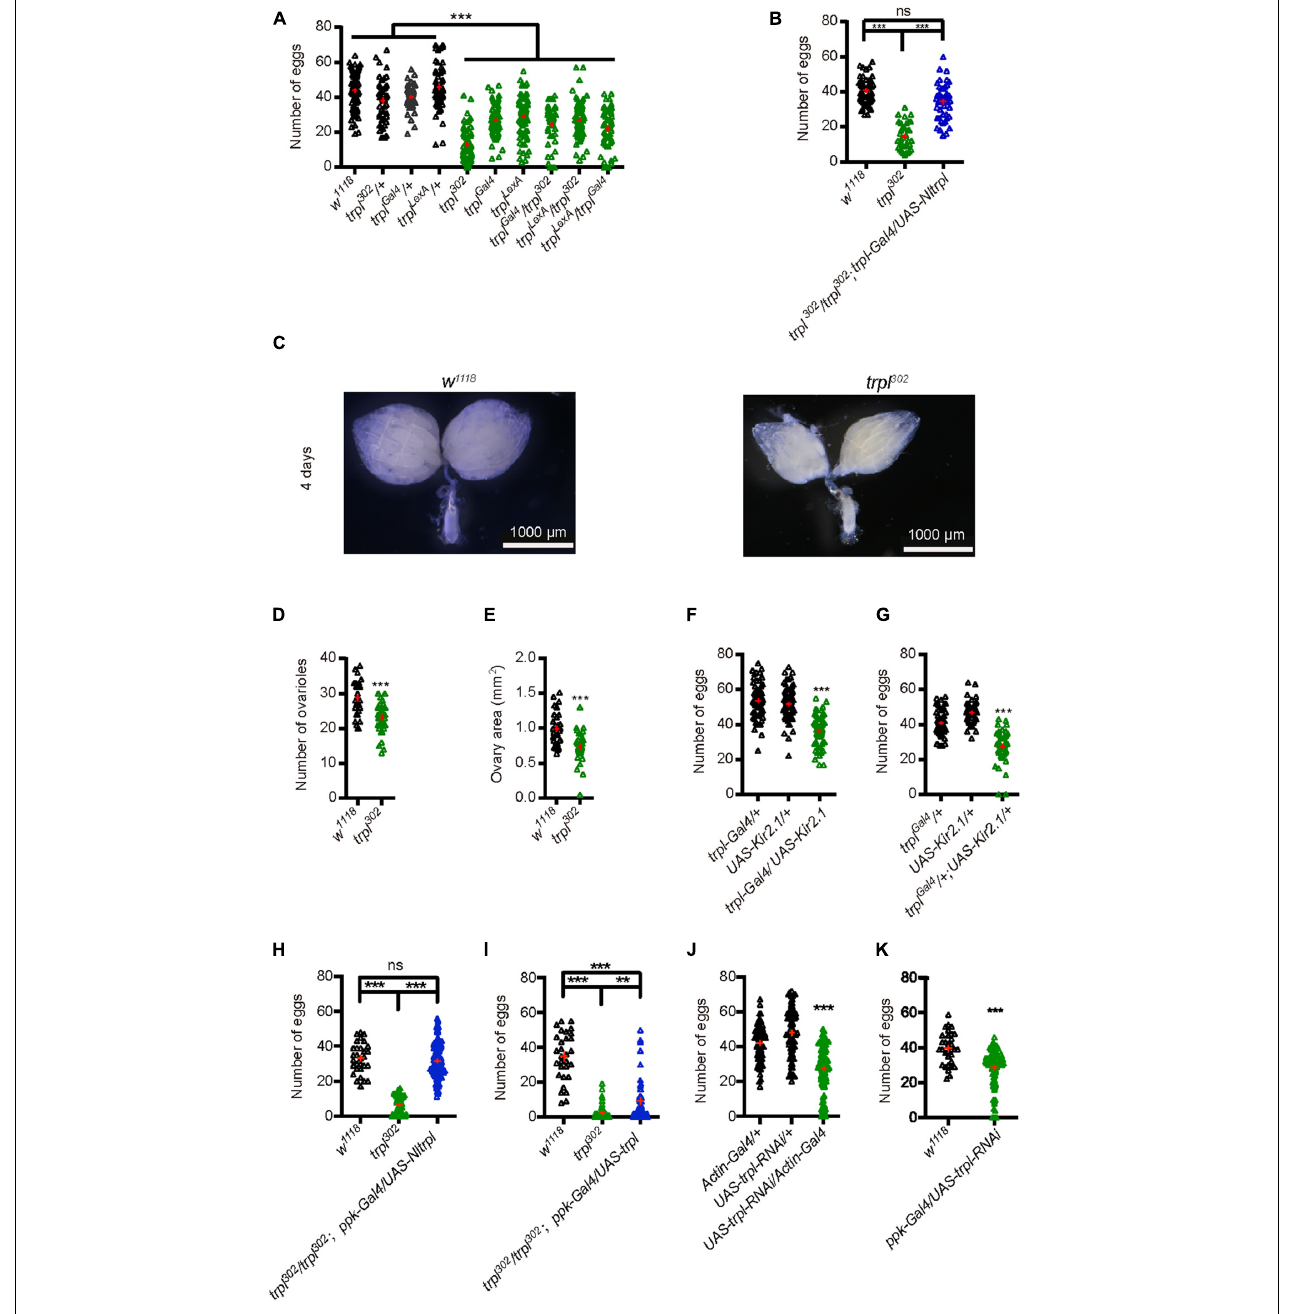
FIGURE 5 | Transient receptor potential-like ( trpl ) is essential for fruit fly egg-laying behavior. (A) Numbers of eggs laid by wild-type and trpl mutant flies. (B) The trpl mutants were rescued by expressing Nltrpl . (C) Ovary development of wild-type ( w 1118 ) and trpl 302 mutants 4 days after eclosion. Ovariole number (D) and ovary area (E) in wild-type and mutant files. Number of eggs was reduced after trpl -expressing neurons were inhibited using Kir2.1 via trpl - Gal4 (F) or trpl Gal 4 (G) . (H,I) Rescue of trpl mutants with a ppk-Gal4 that expressed in oviduct neurons. (J) Number of eggs from controls and mutant flies in which trpl is globally knocked down. (K) Number of eggs from wild type and mutant flies with trpl selectively knocked down in oviduct sensory neurons. *** P < 0.001, one-way ANOVA with Tukey’s multiple comparisons test.